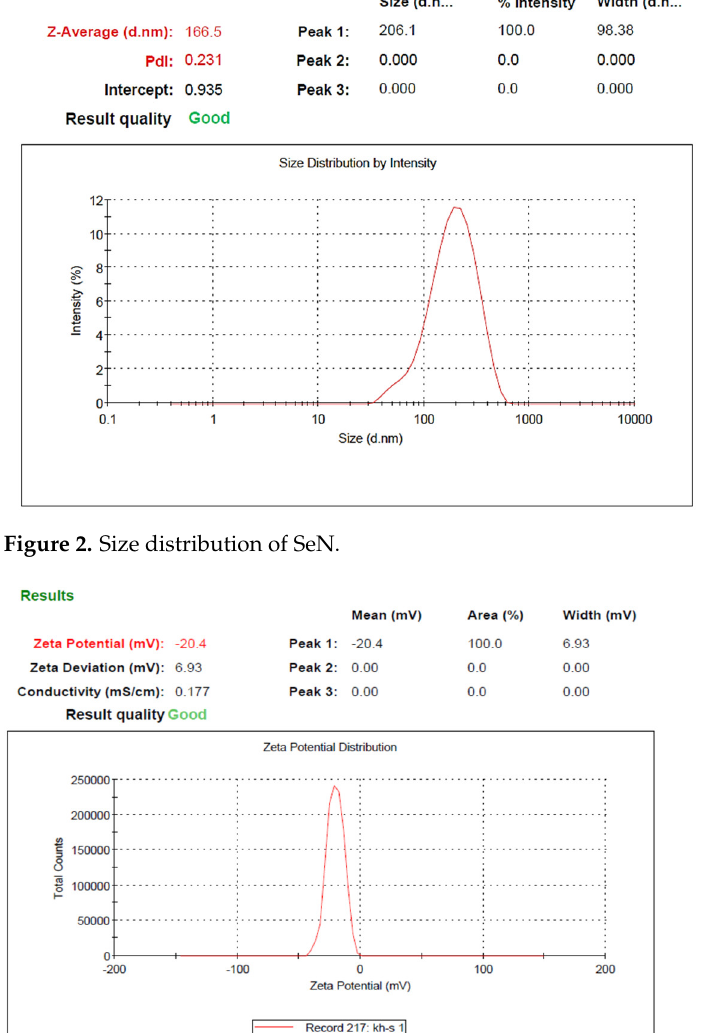
Figure 3. Zeta potential of SeN.